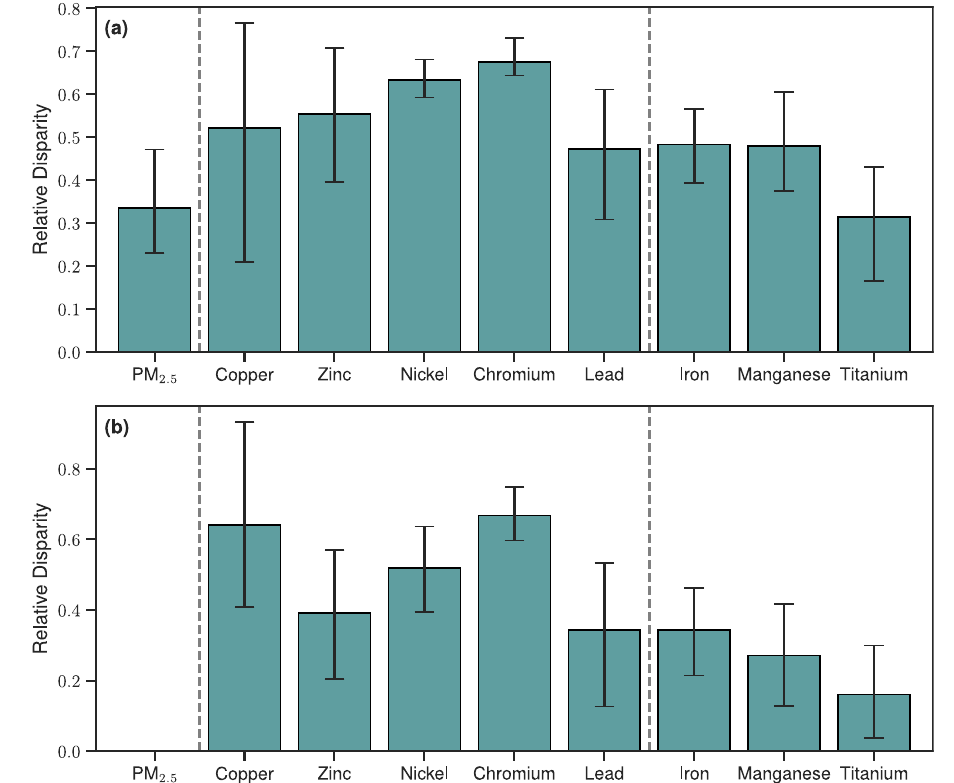
Fig. 3 | Relative disparities across highly segregated, moderately segregated, and well-integrated US counties. Relative disparities calculated from a popula- tion-weighted annual mean concentrations and b mass proportions in the year 2019. The relative disparity quanti fi es the variation in the population-weighted exposures(concentrationsormassproportions)forpopulationslivingineachRRS category relative to the average across the entire population (see Methods). This relative scale allows for a direct comparison between the different chemical com- ponents considered here. A value of 0 indicates perfect equality in population-